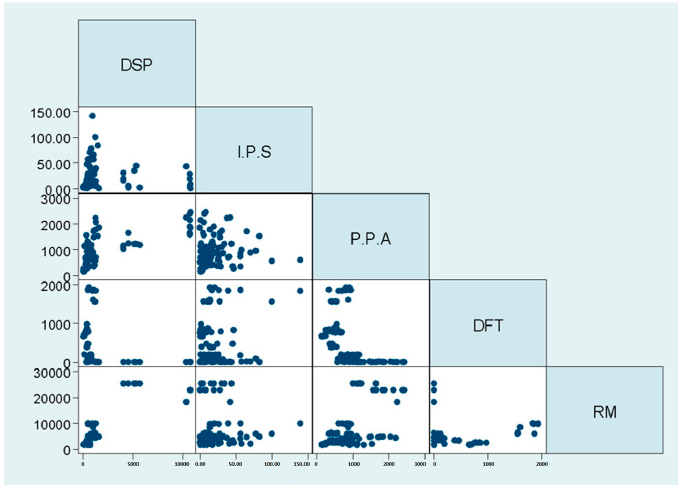
Figure 6. Scatter plot for the availability of the variable (DSP), weighted drought index (IPS),